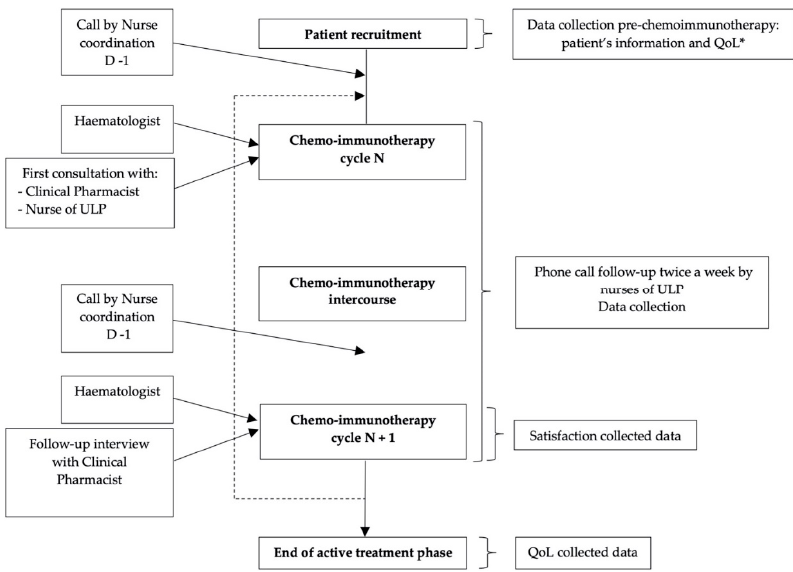
Figure 2. Description of UMACOACH Lymphoma Program. * QoL: Quality of Life; ULP: UMACOACH Lymphoma Program.